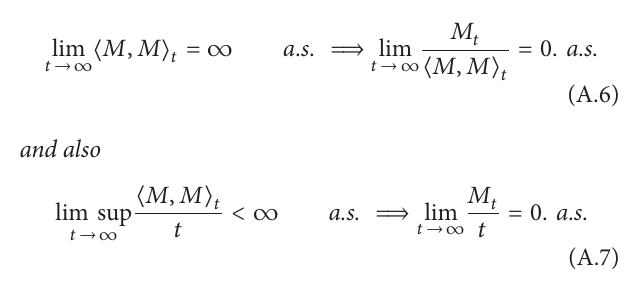
= 0.1 , 𝜎 = 0.1 , and 𝜎 = 0.1 1 2 3